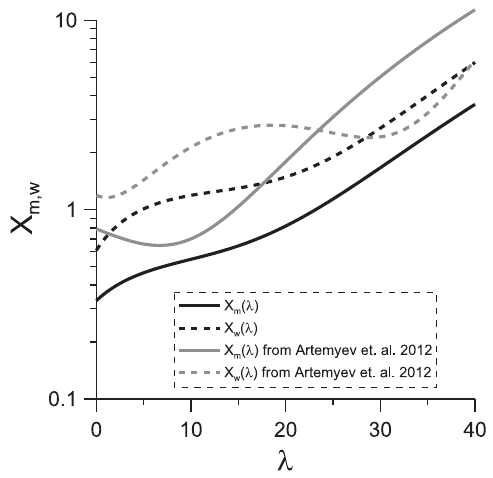
Fig. 6. Mean value X m and variance X w from Eq. (17) are shown by black color, while approximations from Artemyev et al. (2012a) are shown by grey color.